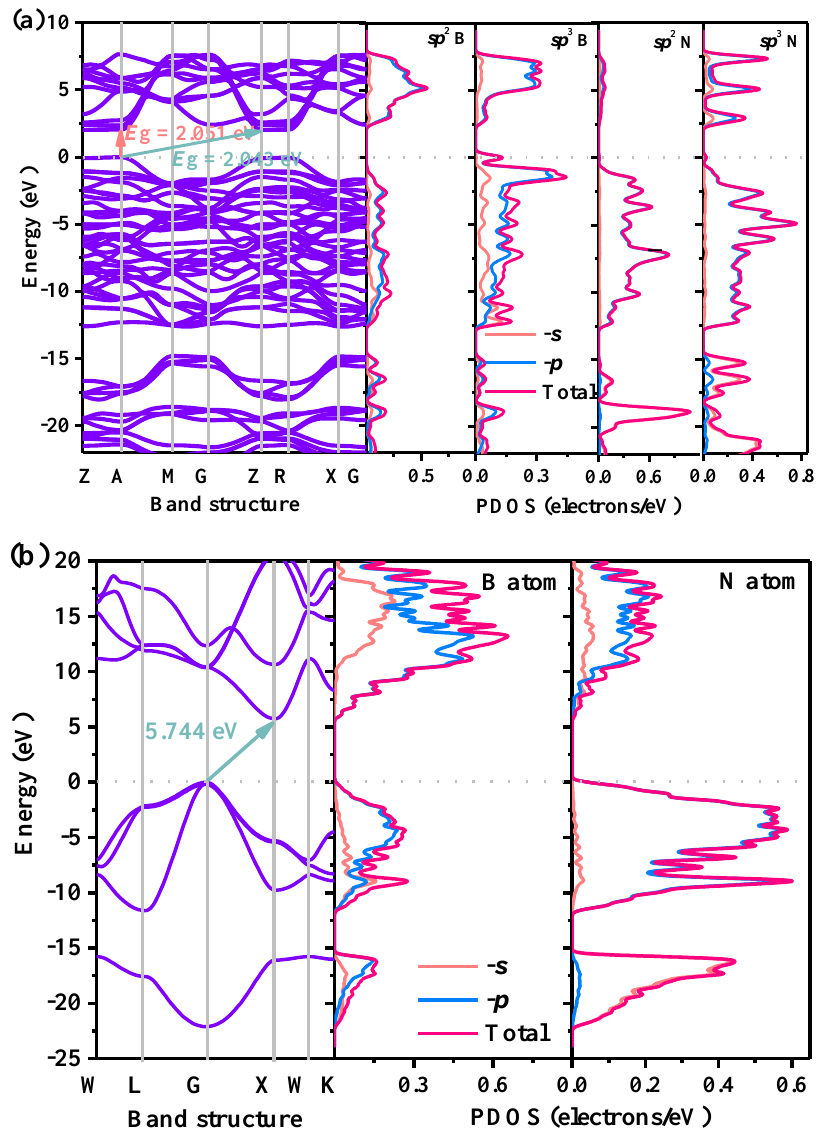
Figure 6. Electronic band structure and partial density of state for P 4/ m BN ( a ) and c-BN ( b ). In addition, the electron localization functions (ELF) of P 4/ m BN and the band de- composed charge densities (BDCD) of P 4/ m BN are shown in Figure 7; the ELF with an isosurface level was set to 0.88, and the isosurface of the BDCD at the CBM and VBM was set to 0.005 eV/Å 3 , respectively. The electron localization at the center of the sp 3 B–B bonds was stronger than that of the sp 2 + sp 2 BN bonds and stronger than that of the sp 3 − sp 3 BN bonds. The band decomposed charge densities (BDCD) of the CBM and VBM for P 4/ m BN are shown in Figure 7b,c, respectively. As shown in Figures 6 and 7b, the CBM